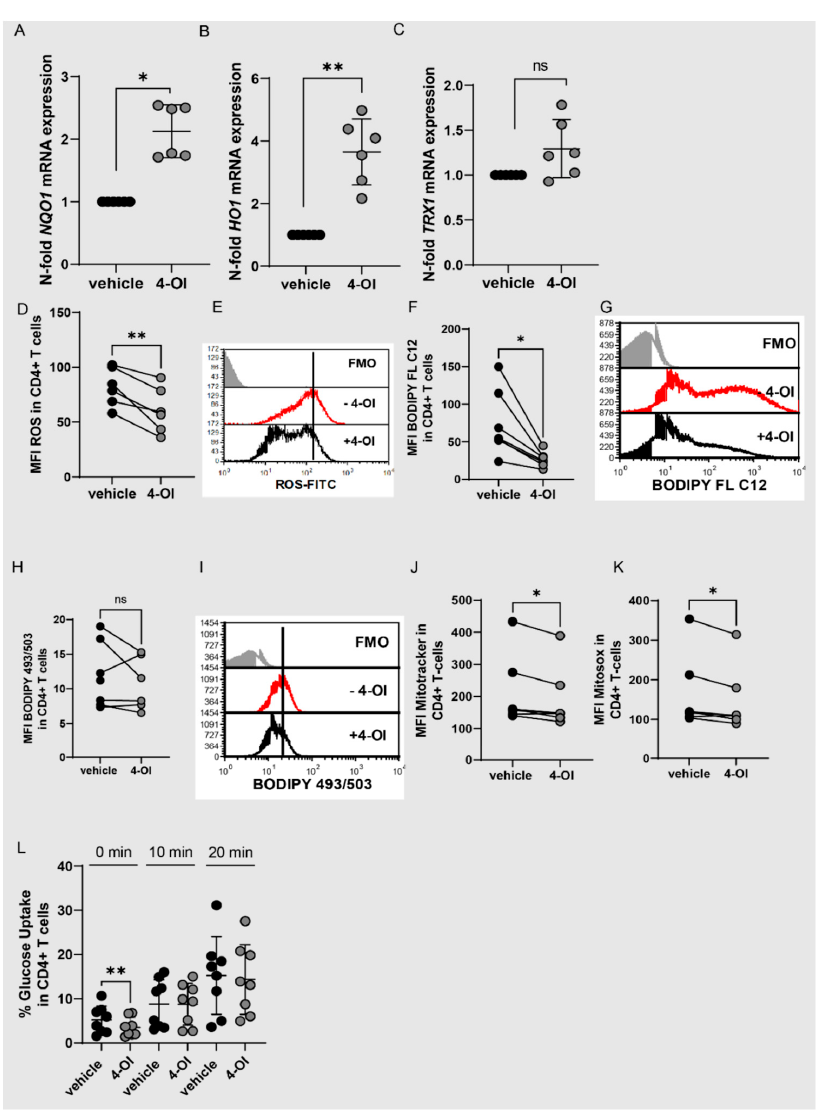
Figure 4. 4-OI activates NRF2 while reducing ROS production and fatty acid uptake. ( A – C ) CD4 + T cells were stimulated with anti-CD3/CD28 for 48 h with 4-OI (20 µ M) or vehicle (w/o 4-OI)